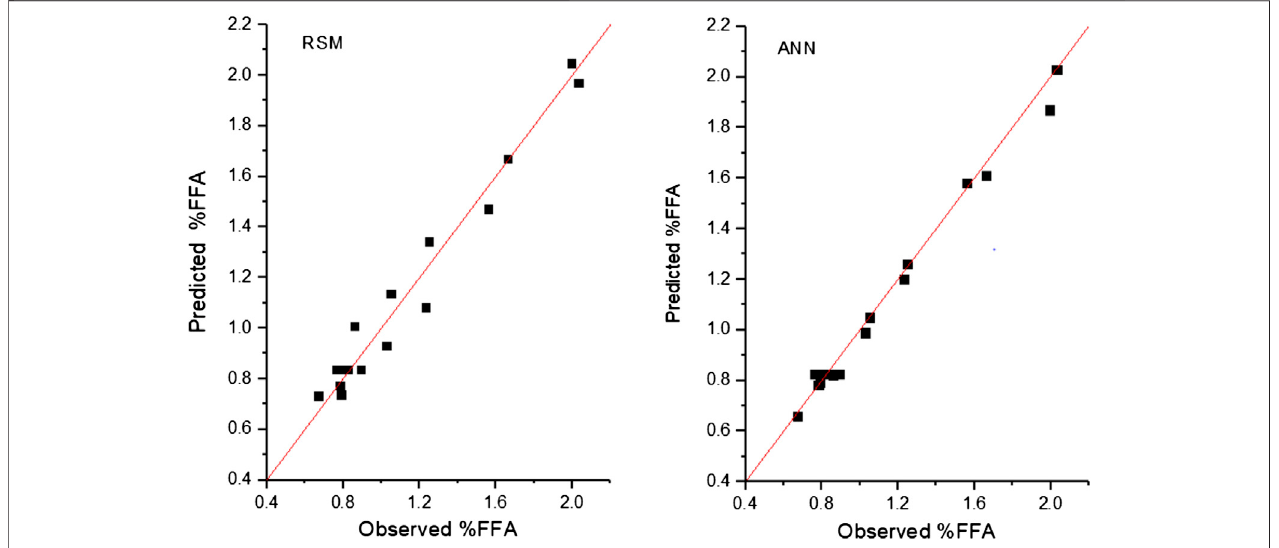
FIGURE 8 | Plots of model predicted %FFA against observed %FFA.